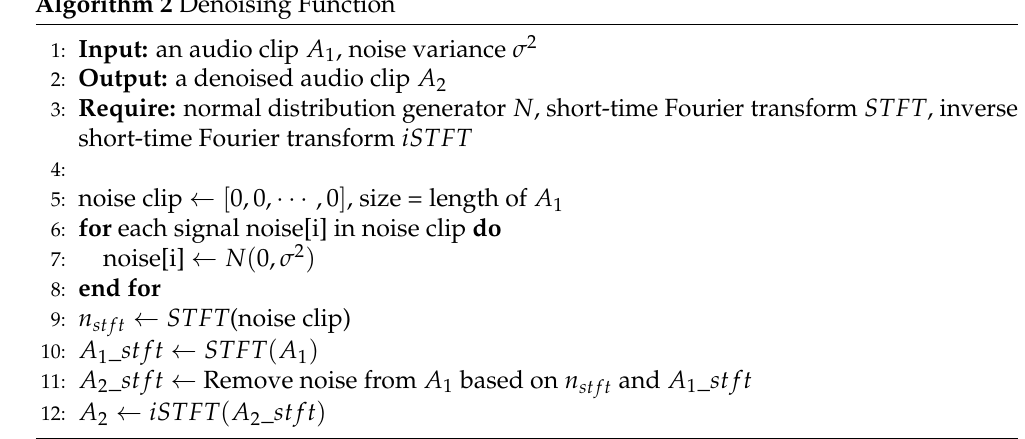
Algorithm 2 Denoising Function